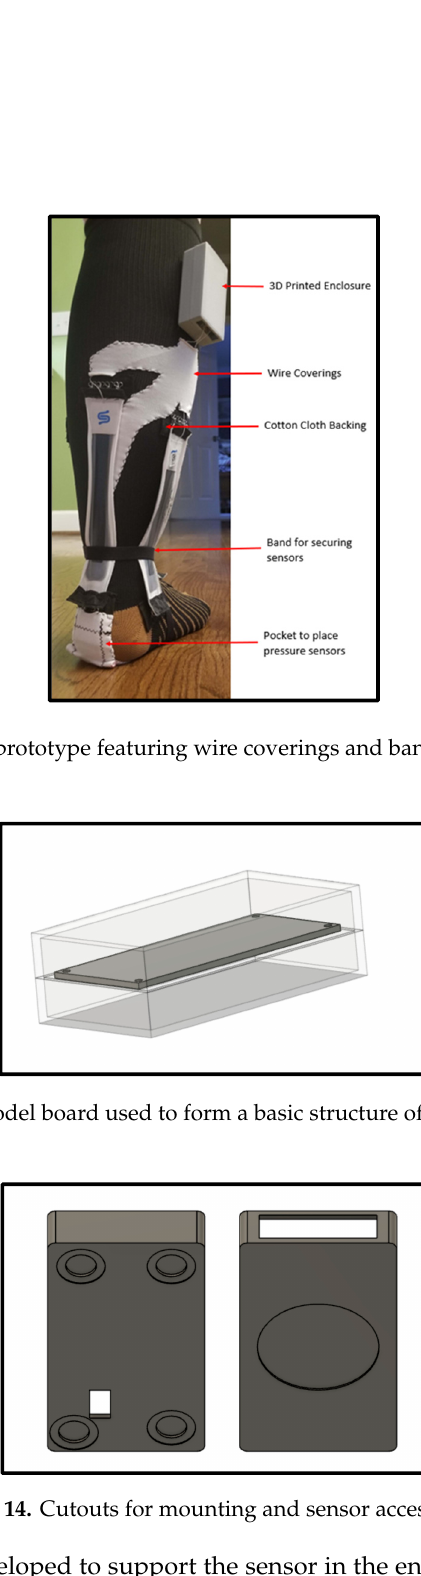
Figure 15. Snap case design for ease of access to the sensor.